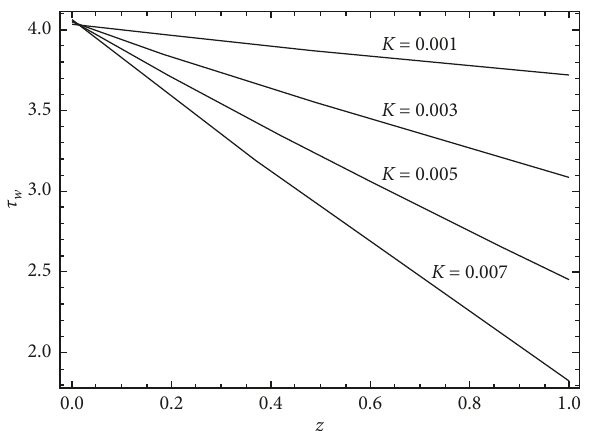
Figure 9: Variation of τ ω with z for different values of K , where P 0 � 43, We 2 � 0.01, n � − 1, and m � 0.5.